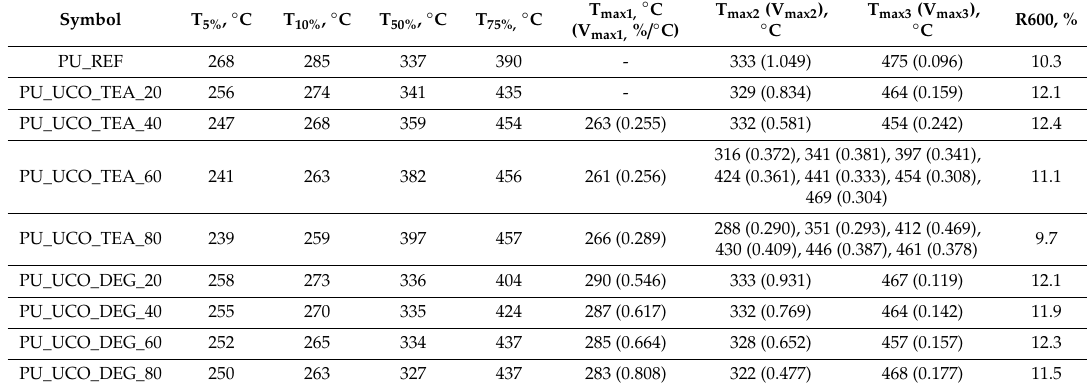
Table 5. Results of thermogravimetric analysis.